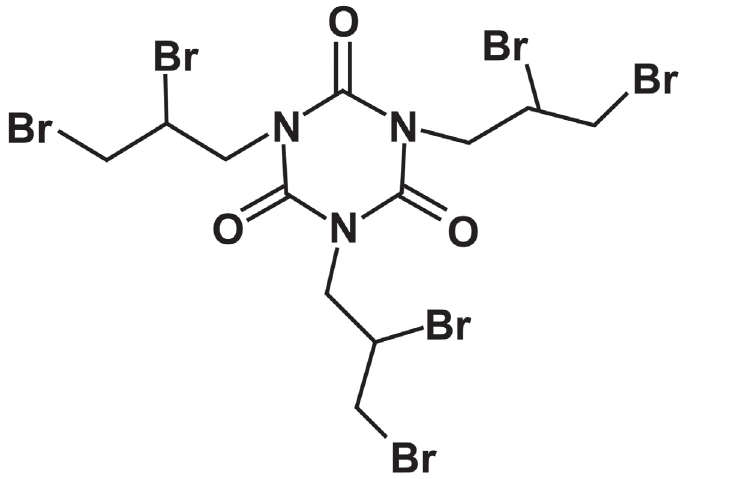
Fig 1. Molecular structure of